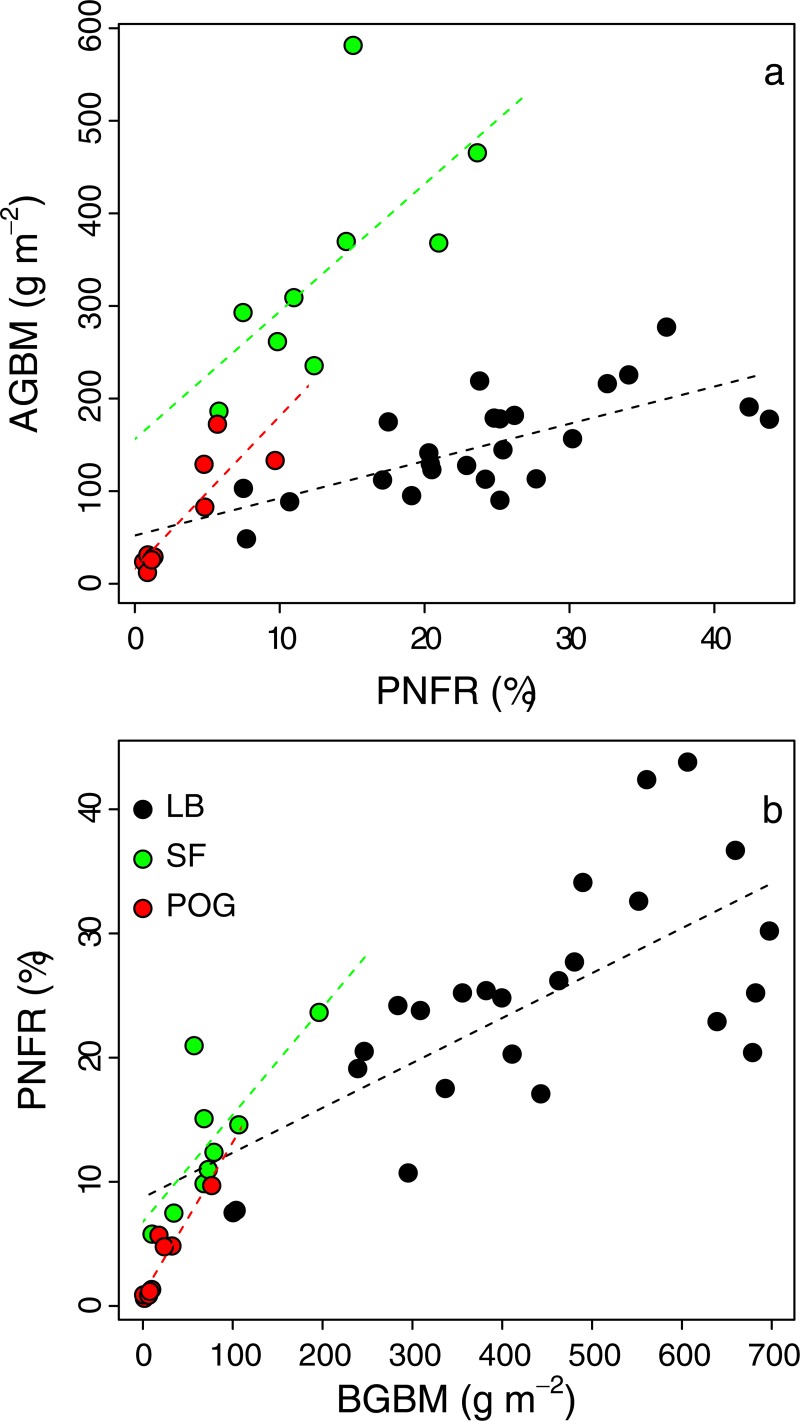
Relationships between the percentage of fertilizer-derived N recovered (PFNR) and aboveground biomass (AGBM; g m-2) and belowground biomass (BGBM; g m-2) in the three study plant species.(a) Relationship between PFNR and AGBM; y = 52.12 + 4.02x (R2 = 0.49; P < 0.001) for LB; y = 156.2 + 13.77x (R2 = 0.44; P = 0.05) for SF; y = 16.38 + 16.46x (R2 = 0.74; P = 0.005) for POG. (b) Relationship between BGBM and PFNR; y = 8.72 + 0.036x (R2 = 0.47; P < 0.001) for LB; y = 6.77 + 0.086x (R2 = 0.58; P < 0.05) for SF; y = 0.91 + 0.123x (R2 = 0.87; P < 0.001) for POG. LB, SF and POG stand for lowbush blueberry, sweet fern and poverty oat grass, respectively.